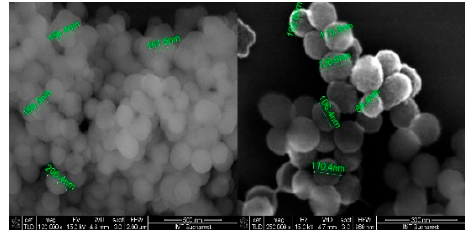
Figure 1. SEM analysis of encapsulated